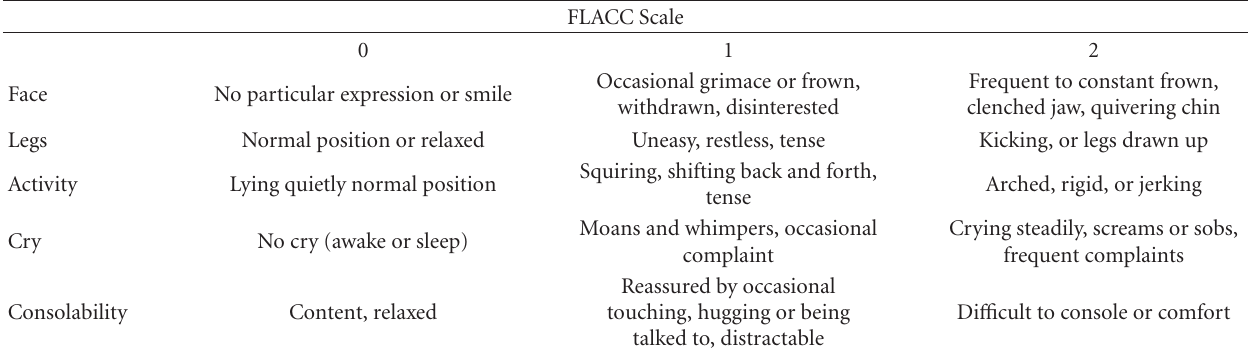
Table 3: Scoring system for infants, young children, cognitively impaired children, anxious children, and any child unable to use faces ladder. Paediatric Pain Assessment: FLACC scale. This pain assessment tool can be used in children < 4 years and those with cognitive impairment or unable to use the “FACES” ladder.